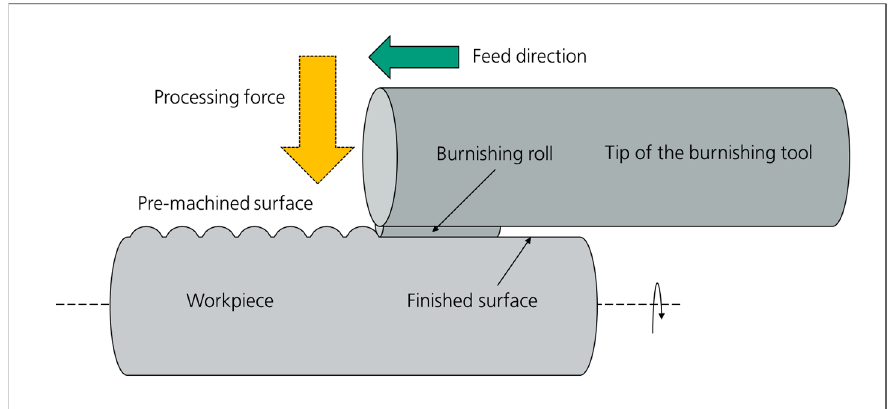
Figure 1. Schematic drawing of a roller burnishing process. The burnishing roll is moved over a turning workpiece with a pre-machined surface roughness. Due to high process forces, the roughness of the workpiece is deformed into a flat surface during the burnishing operation. Source: own-elaboration.